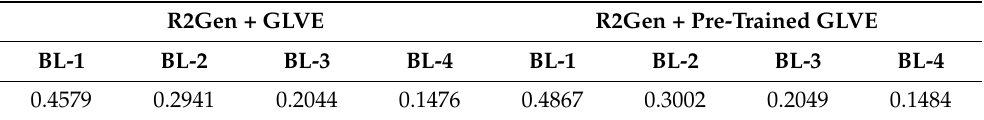
Table 1. The performance of the baseline with the GLVE and the baseline with pre-trained GLVE. One can observe that pre-trained GLVE leads to a better performance with the same